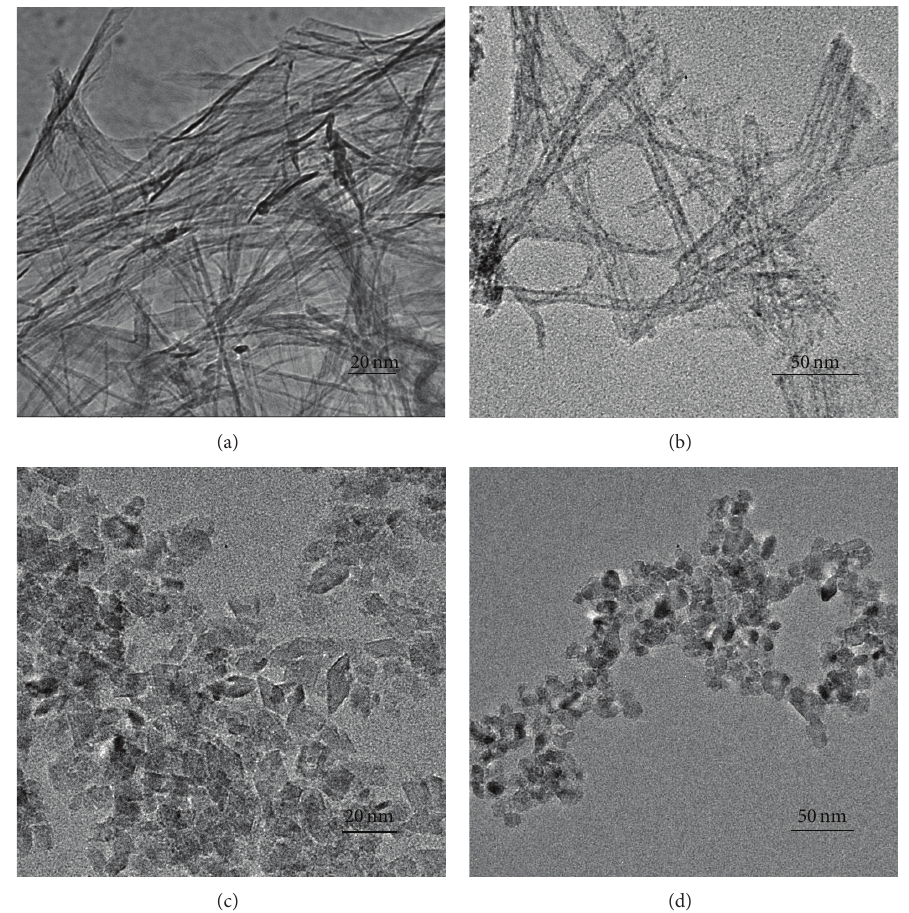
Figure 3: TEM images of (a) NTA; (b) NTA ion-exchanged with Ce(NO 3 ) 3 ; (c) 0.1% CeO 𝑥 /TiO 2 nanoparticles after hydrothermal method; (d) 0.1% CeO 𝑥 /TiO 2 nanoparticles after